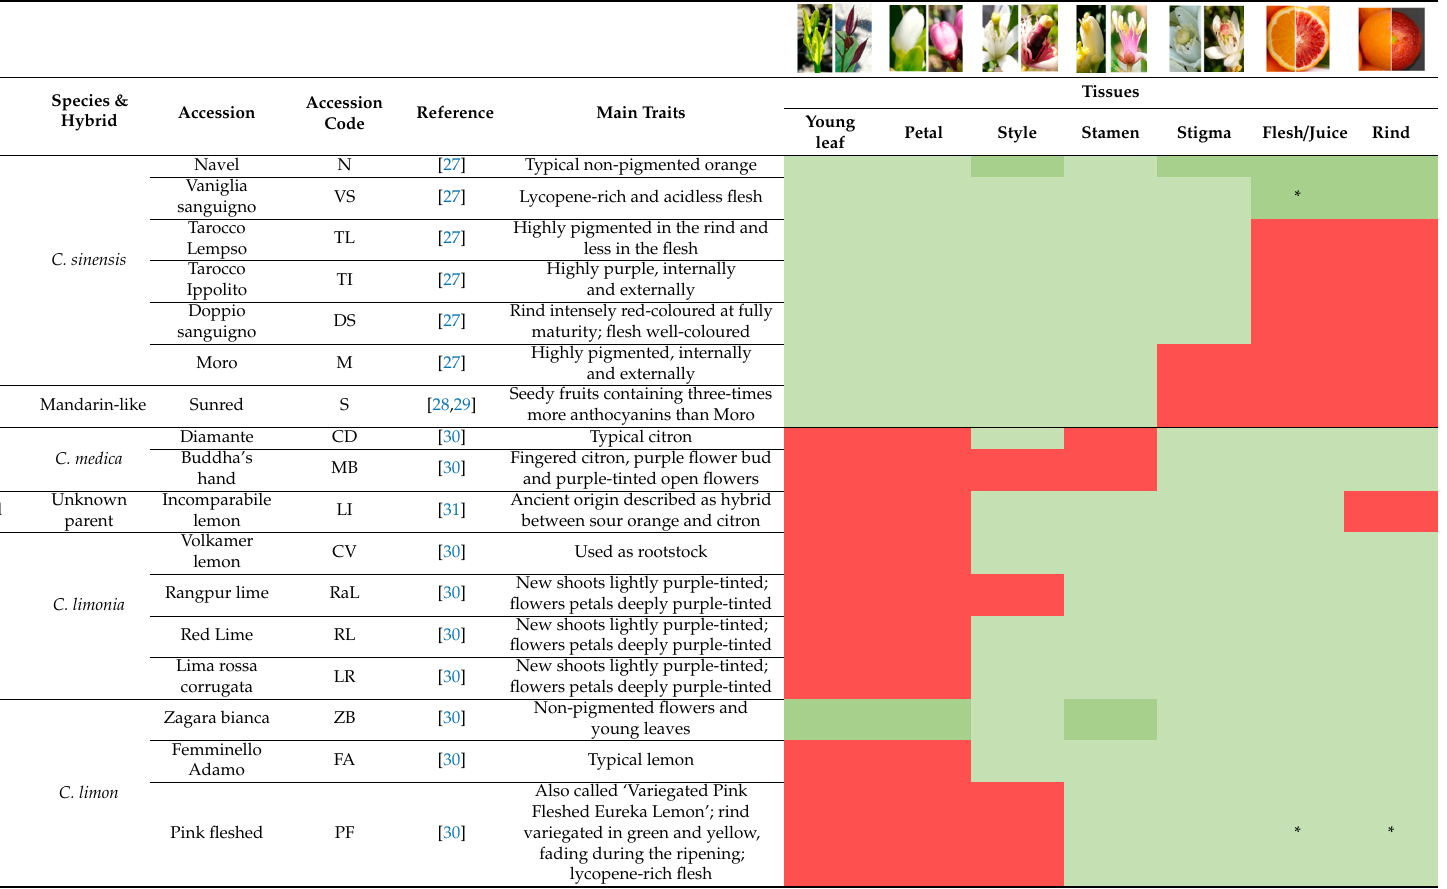
Table 1. Tissues and species evaluated in the study. The origins of the species and the hybrid for each accession are reported, as well as the accession code used in the qRT-PCR data, the references and the main traits characterizing each accession. Bright green boxes are used for negative controls, bright red boxes are used for anthocyanin-rich tissues. The corresponding light green and light red boxes refer to unpigmented and pigmented tissues collected for the expression analysis. Green boxes with asterisks refer to lycopene-rich tissues. # The pigmentation of S. disticha fruits could be due to the seedling origin of the accession located in the ‘Council for Agricultural Research and Economics’ bank germplasm.